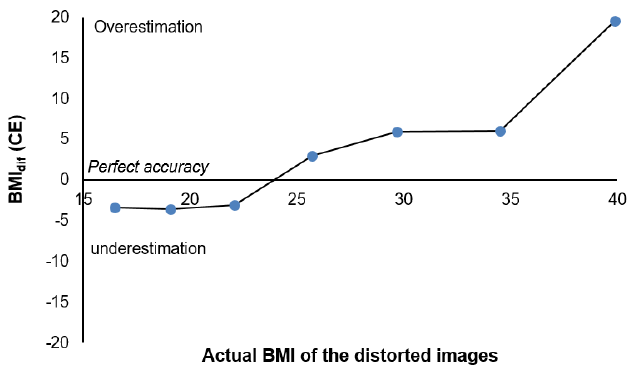
Figure 3. Magnitude estimation of perceived size of distorted body im- ages (psychological scale) and the actual size of distorted body images (physical scale) representing the CE (BMI